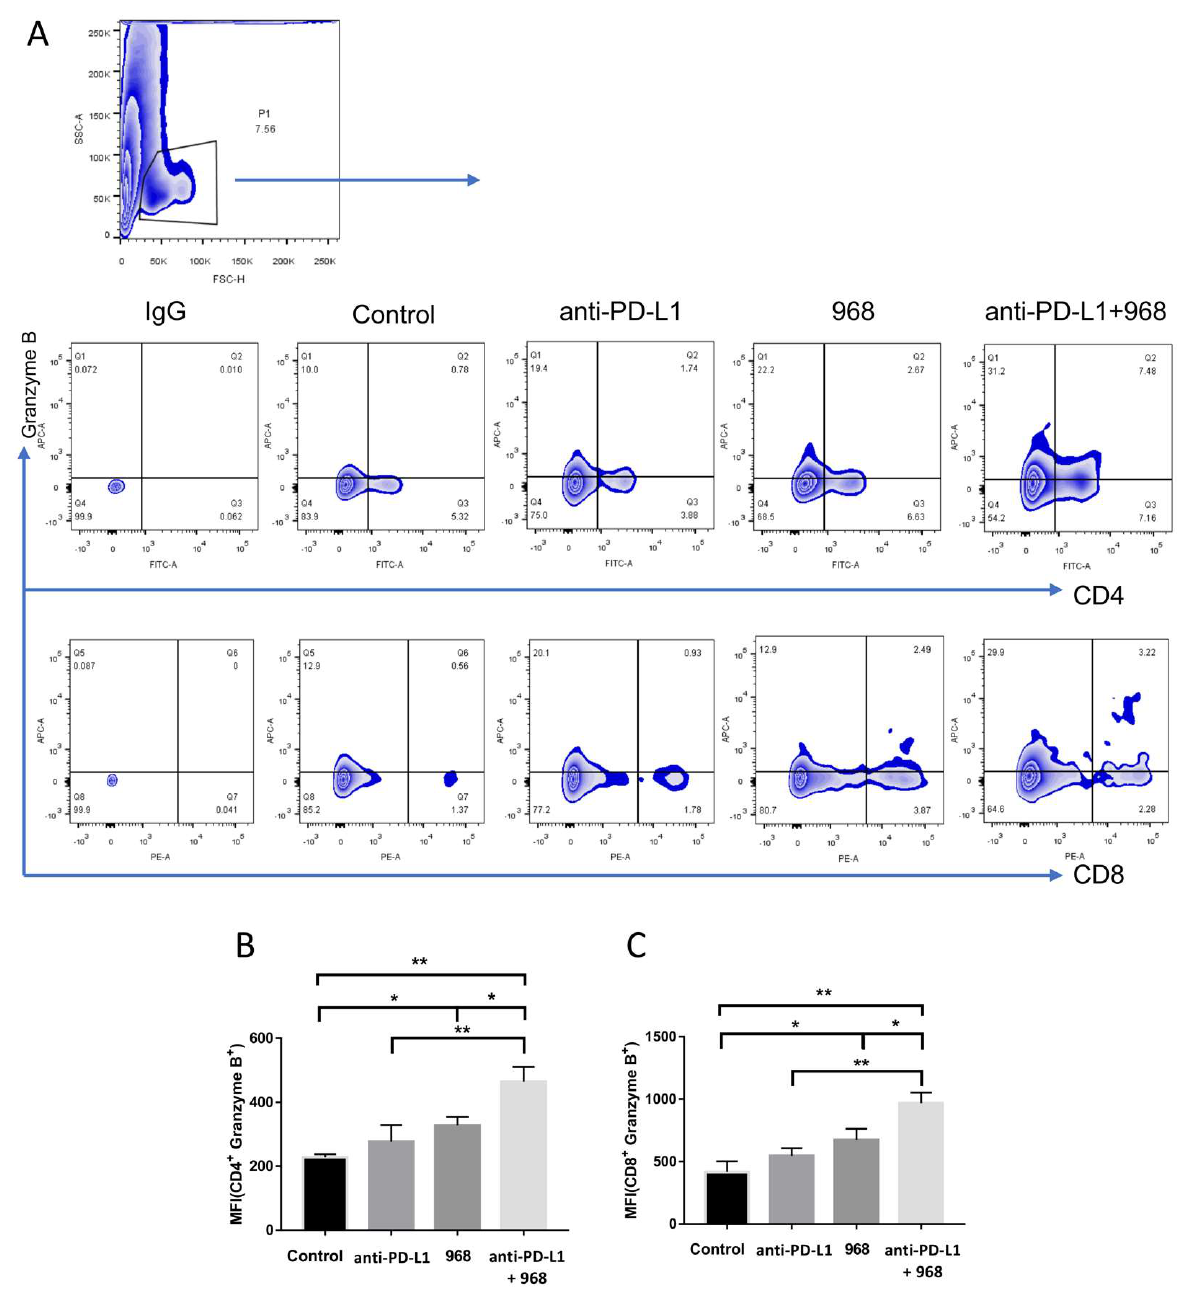
Figure 5. The combination of glutaminase inhibitor 968 with anti–PD–L1 antibody increased the granzyme B secretion of CD4 + T cells and CD8 + T cells that isolated from tumors. ( A ) Representative results of granzyme B–positive cells in CD4 + T cells (upper layer) and CD8 + T cells (lower layer). ( B , C ) Statistical analysis of granzyme B–positive CD4 + T cells (B) and granzyme B–positive CD8 + T cells ( C ) that infiltrated into tumors from the four groups. (* p < 0.05, ** p < 0.01). The number of tumor infiltrated lymphocytes is thought to be the major component reflecting the anti-tumor immune response [32]. Studies also revealed the positive